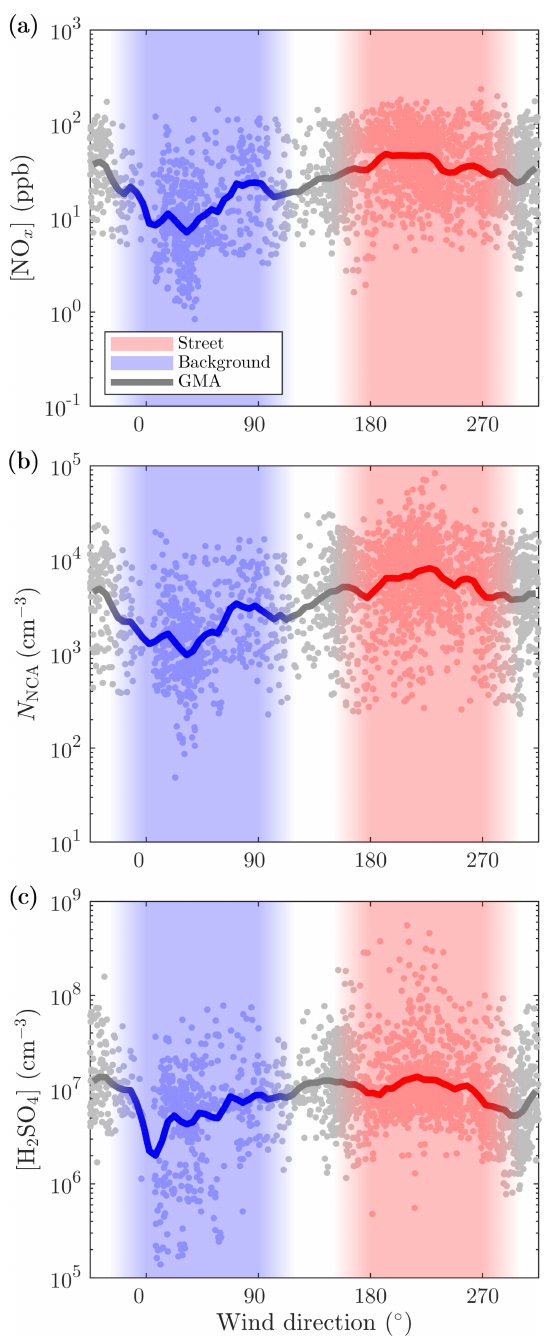
Figure 8. The 10min averages of the (a) NO x , (b) NCA, and (c) H 2 SO 4 concentrations measured with different wind directions. Wind velocities smaller than 0.5ms − 1 are excluded. GMA denotes geometric moving average.